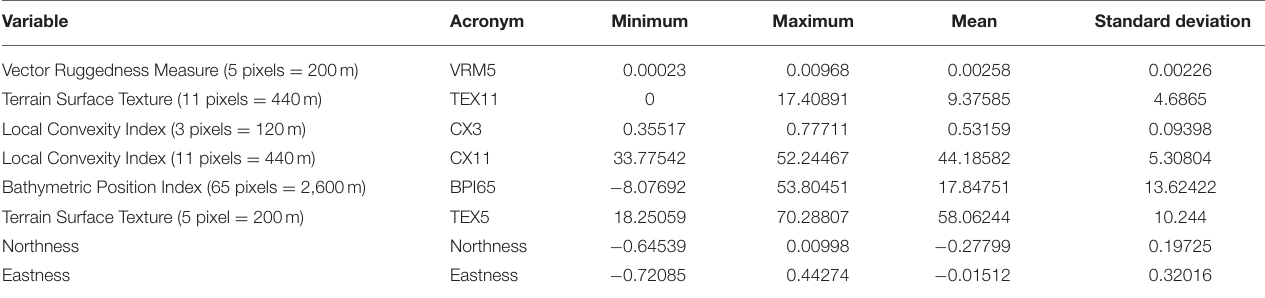
TABLE 2 | Range of values (Minimum and Maximum) used for the selection of the potential coral mounds in the Geomorphometric proxies method deriving from the 22 known coral mound variables.